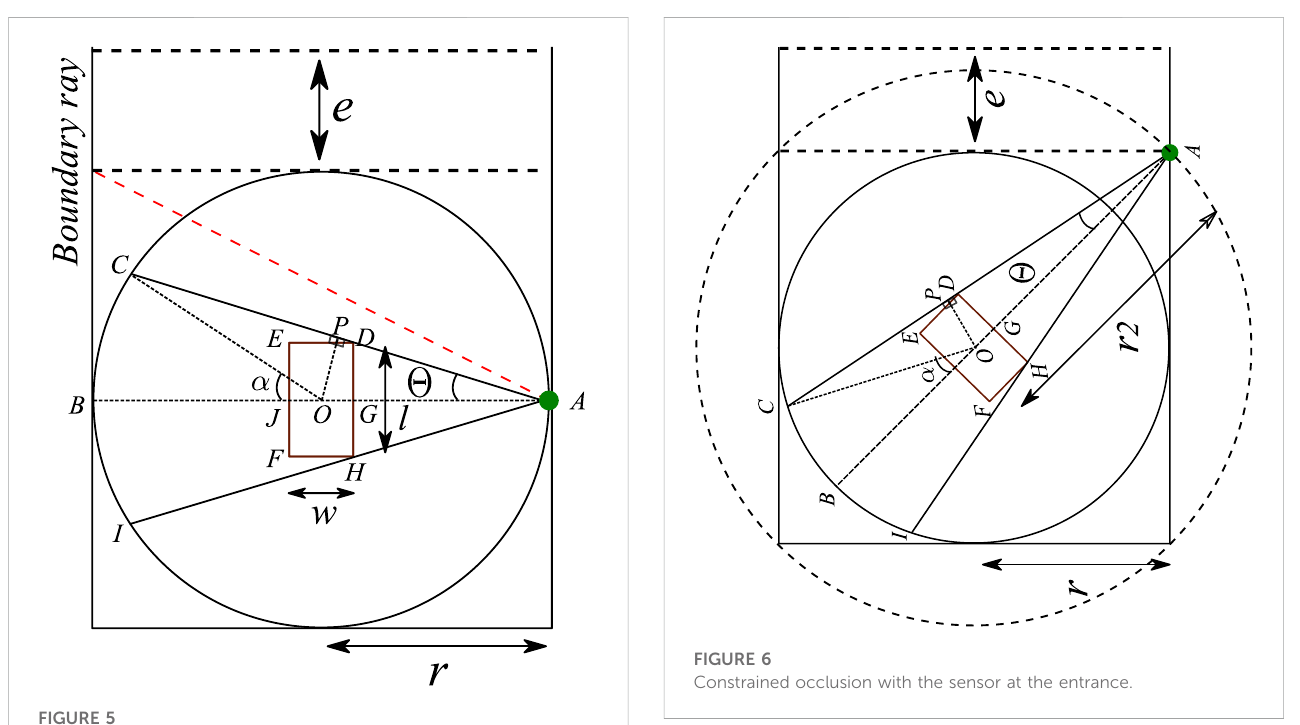
FIGURE 5 Constrained occlusion with the sensor at the middle of the fence.